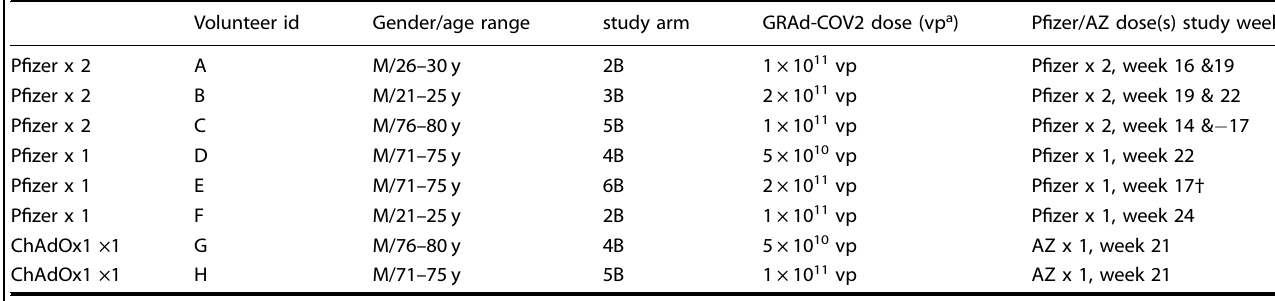
Table 1. Volunteers characteristics and vaccination